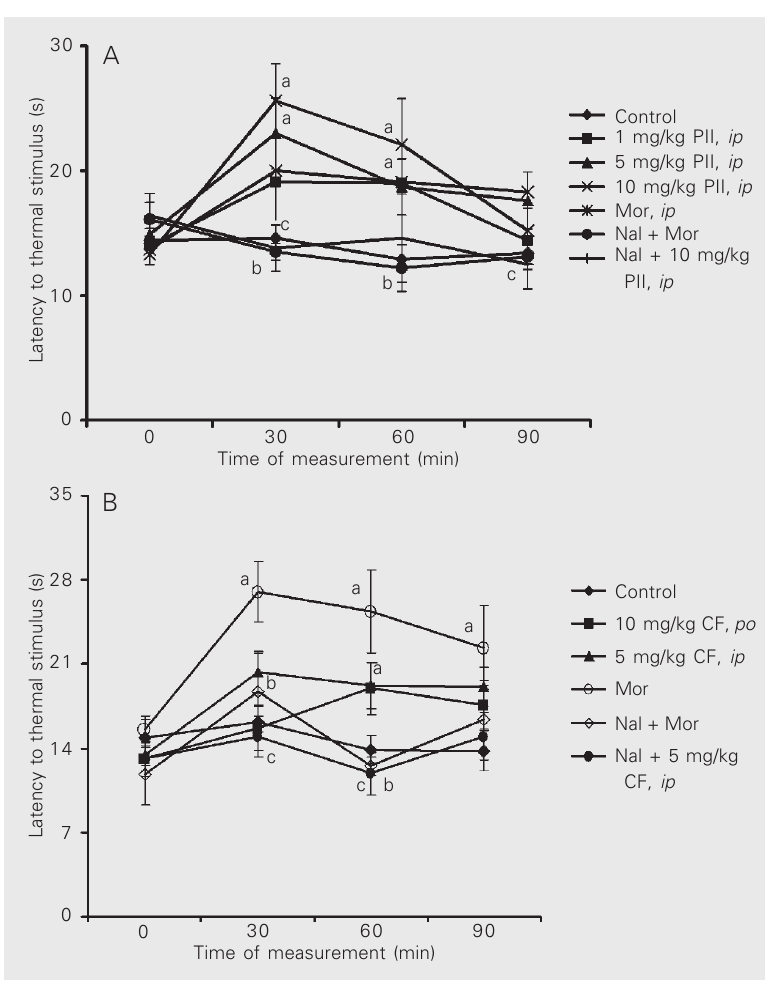
Figure 1. Effect of PII (A) and carbohydrate (B) fractions from Bryothamnion seaforthii on the hot-plate test in male mice. Data are reported as means ± SEM. P < 0.05 a vs controls, b vs morphine, c vs 10 mg/kg PII or 5 mg/kg CF at the same period of time (ANOVA and Bonferroni as a post hoc test). CF = carbohydrate fraction; Mor = morphine, 4 mg/kg, ip ; Nal = naloxone, 2 mg/kg, sc